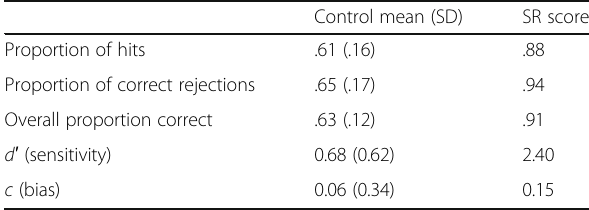
Table 5 Orthogonally rotated component loadings for factor analysis of the experimental group ’ s performance on the four face recognition tests, including hits and correct rejections Table 4 Control mean (SD) and SR ( N = 1, only one individual outperformed controls on this task) scores on the Crowds test Control mean (SD)